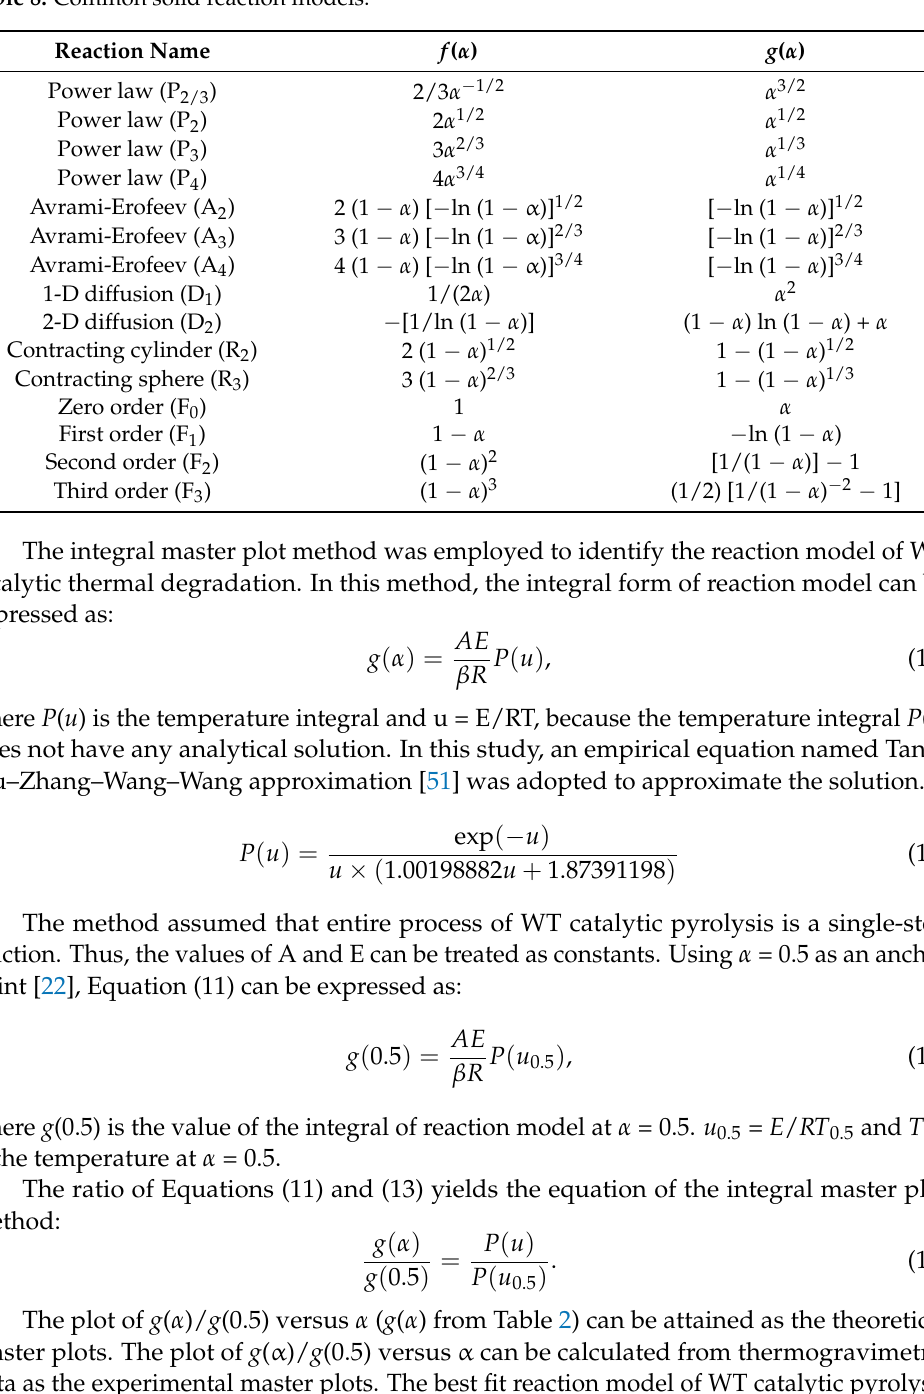
Table 8. Common solid reaction